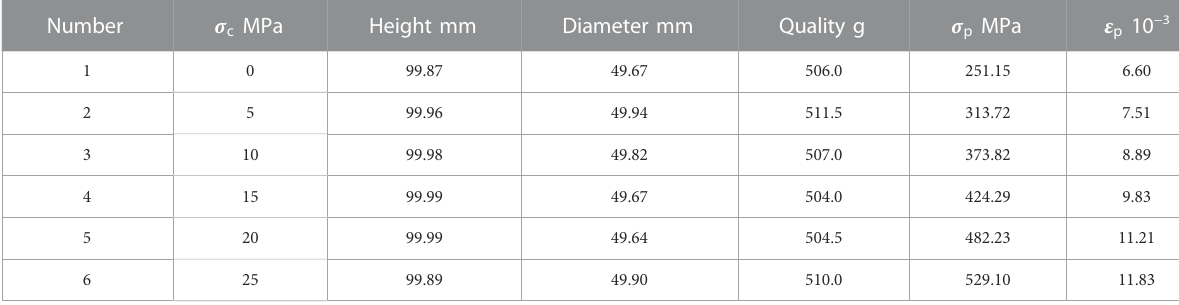
TABLE 1 Results of rock compression testing.